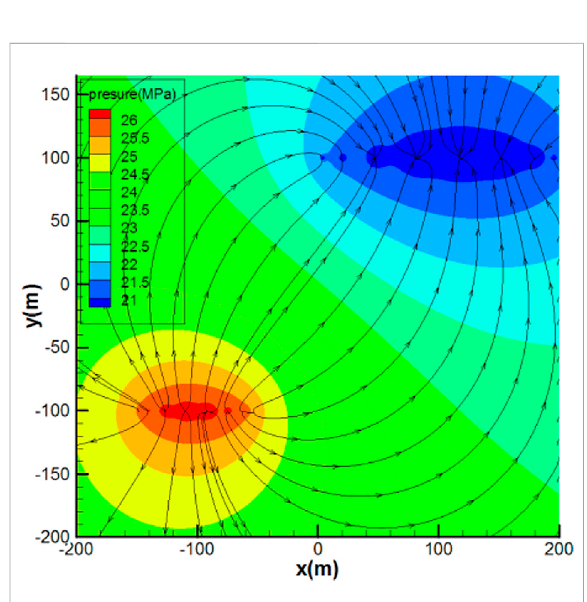
FIGURE 6 Relationship between reservoir permeability and starting pressure.